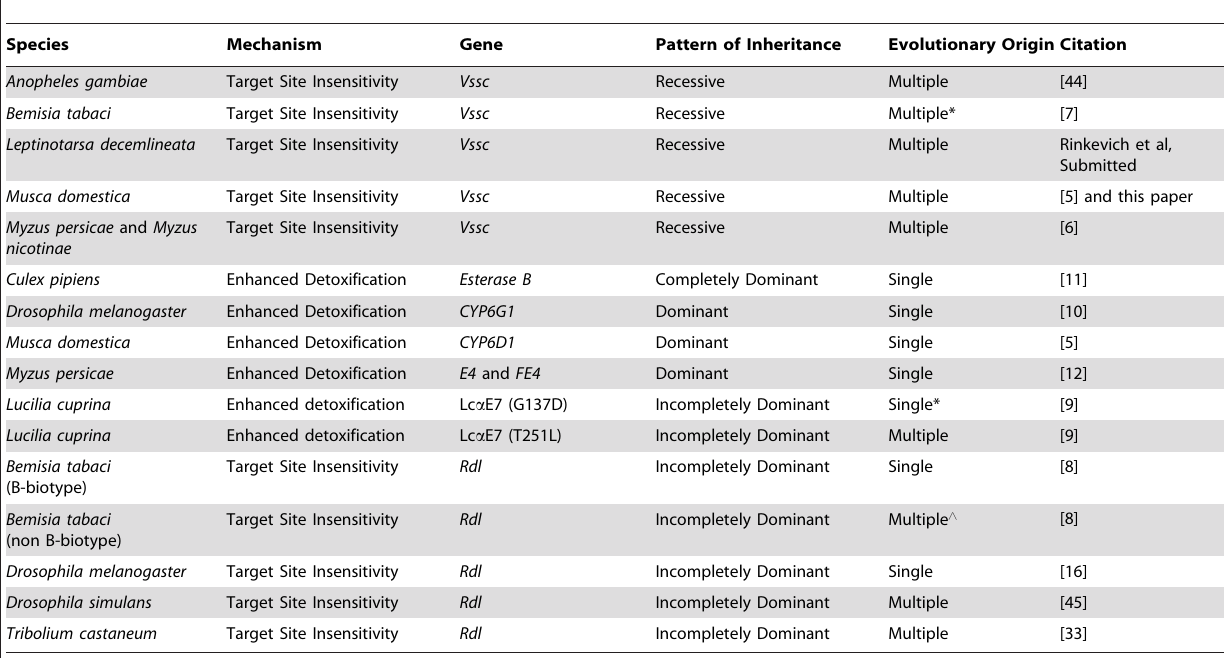
Table 2. Resistance mechanisms, patterns of inheritance, evolutionary origins and prevalence of mutations conferring insecticide